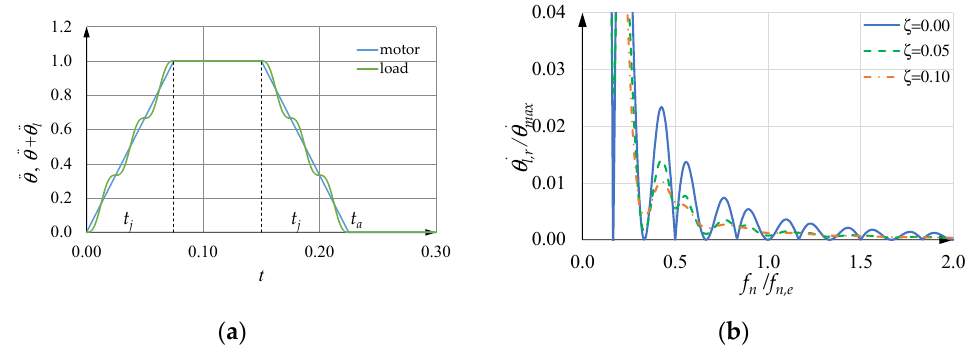
= f f ; ( b ) sensitivity curve Figure 16. ( a ) Motor and load acceleration when t n n,e